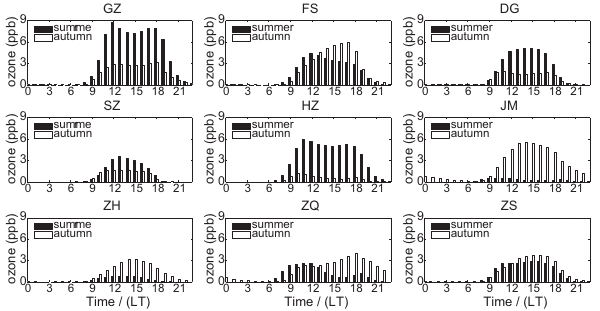
Fig. 12. Comparison of BVOC impacts on surface ozone in PRD cities in summer and in